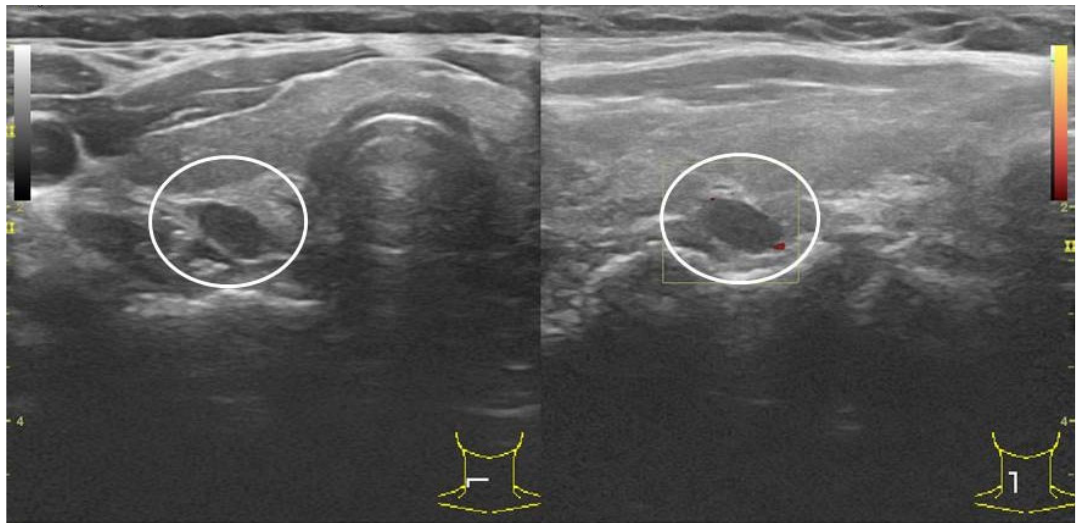
Figure 3. Small, slightly enlarged (5 × 8 × 8 mm) right superior parathyroid gland. No PHPT or iPTH ‐ WC elevated.